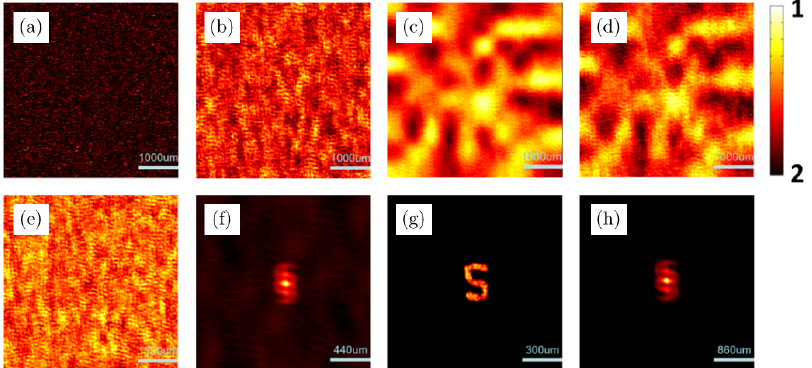
Fig. 5. Simulation result for an intuitive illustration of our method. (a) is a coherent speckle pattern, (b) is an incoherent speckle pattern by summing 2000 coherent ones, (c) and (d) are the same disturbance added to two di®erent incoherent speckle patterns, respectively. (e) is a di®erence of (c) and (d). (f) the autocorrelation of (e). (g) the reconstructed image. (h) is the autocorrelation of the number \5" itself.